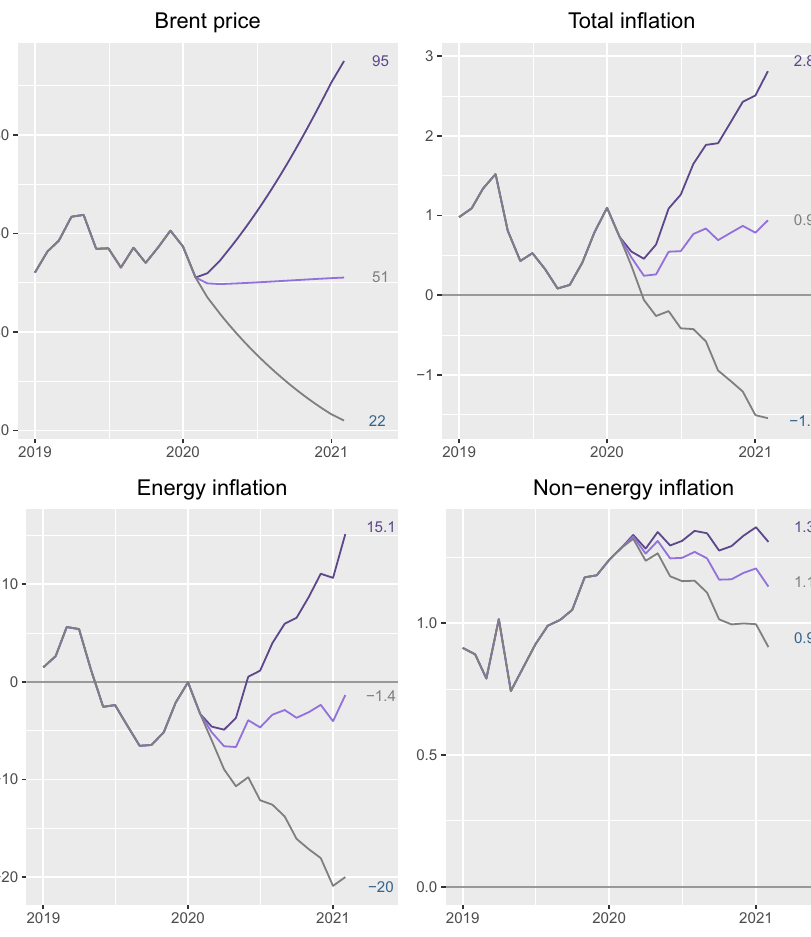
Fig. 6 Forecasts between 2020.03 and 2021.02 based on the scenarios depicted in Table 6 for Brent prices and the corresponding 12-month percent rate for total, energy and non-energy CPI in